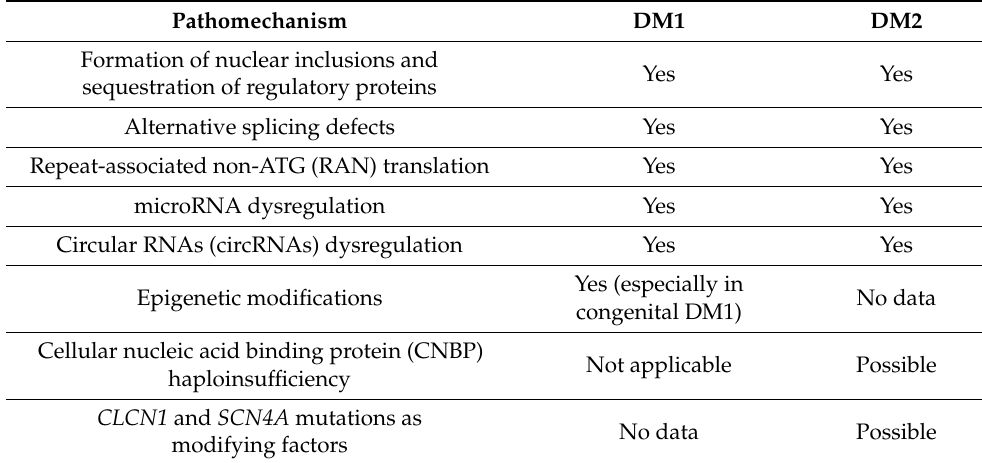
Table 4. Postulated pathomechanisms in DM1 and